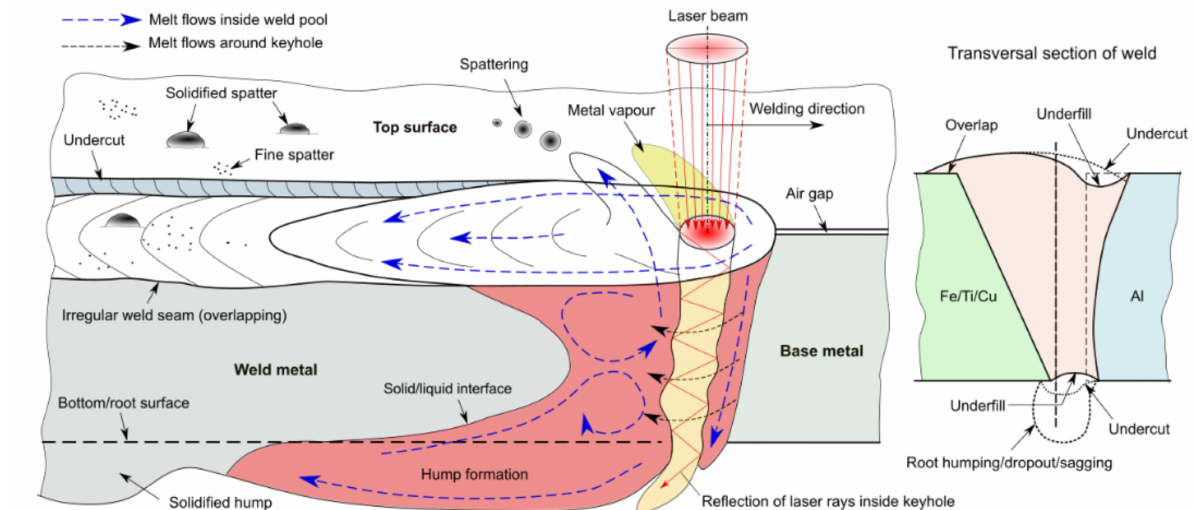
Figure 4. Common external imperfections in LBW during full penetration mode (with focused laser beam) using V-groove butt preparation. Based on